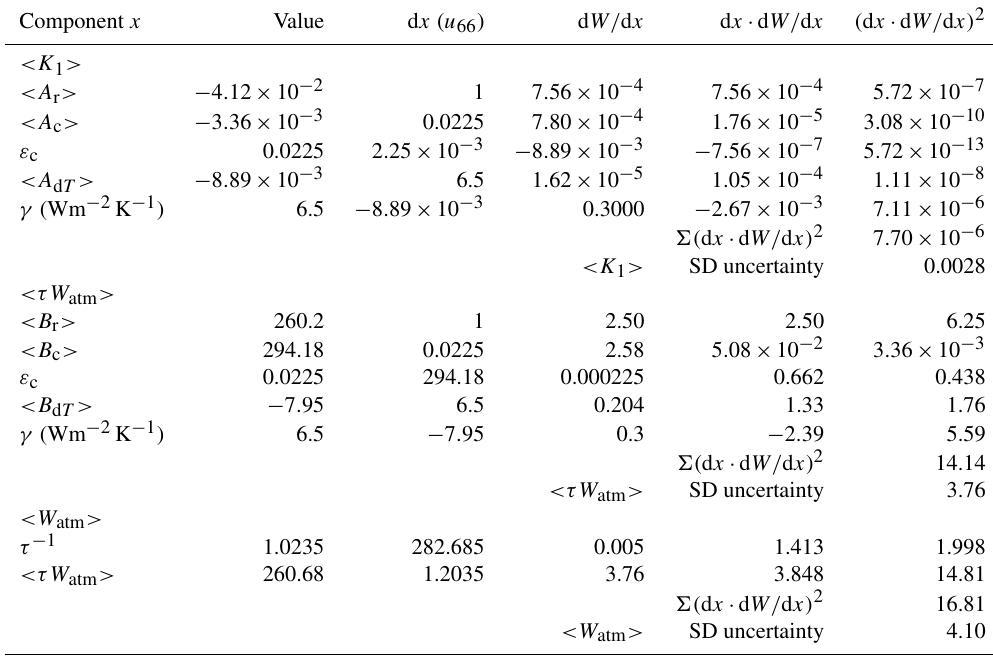
Table 8. The standard uncertainty calculation for <K 1 > , <τW atm > and <W atm > by linear LSQ regression of Eq. (18). The units of the slope components ( <A x > ) are Wm − 2 µV − 1 , while the intercept components are Wm − 2